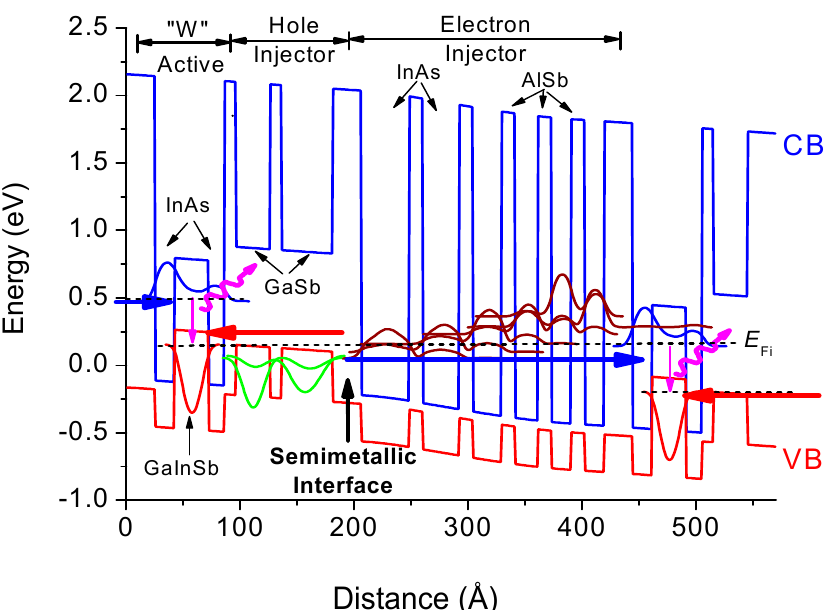
Figure 2. Band diagram of 1½ stages of the ICL active core. Probability densities and zone-center energies (indicated by the wavefunction zero points) for some of the most important subbands are superimposed. The probability densities for the active electron (hole) subbands are indicated with blue (red) lines, while those for the injector-electron (hole) subbands are indicated with wine-colored (green) lines. The blue (red) arrows indicate the position of the quasi-Fermi levels in each stage. The layer structure of one period can be found in Ref. [70], from which this figure is adapted.